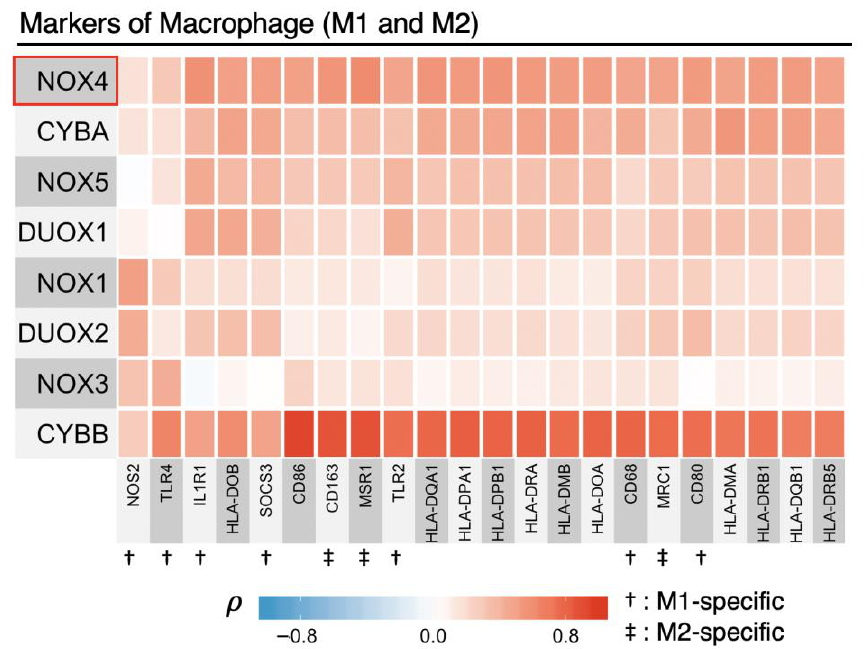
Figure 5. The source of CYBB (NOX2) is likely due to tumor-associated macrophages (TAMs ). Spearman’s rank correlation coefficients, 𝜌 , were calculated in the Final Pan-Cancer Dataset to assess for monotonic relationships between the individ- ual NADPH oxidases and canonical markers of M1 and M2 macrophages. CYBB ( NOX2 ) expression strongly correlates with most markers of M1 and M2 classification of macrophages. A key to gene abbreviations listed is provided in Table